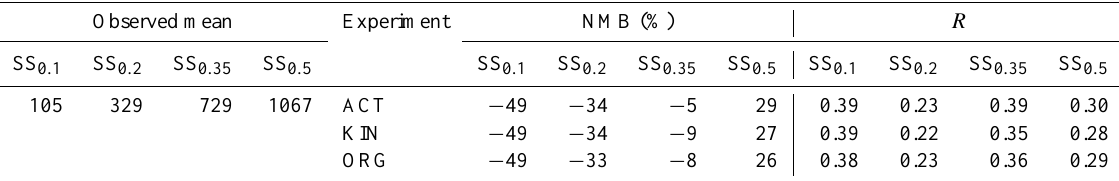
Table 5. Summary statistics for CCN number concentration at several supersaturations (SS = 0.1, 0.2, 0.35, 0.5%). The observed mean, normalized mean bias (NMB) and correlation coefficient ( R ) are calculated between simulated and observed number concentrations at the T0 site during the 7–16 June 2010 period.